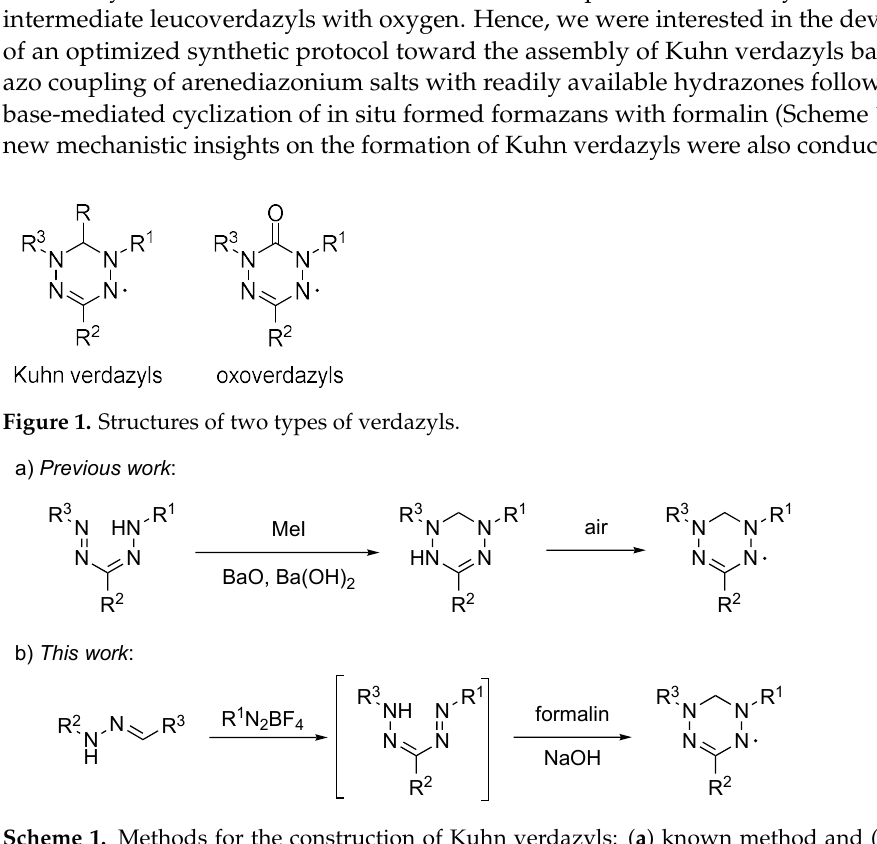
Figure 1. Structures of two types of